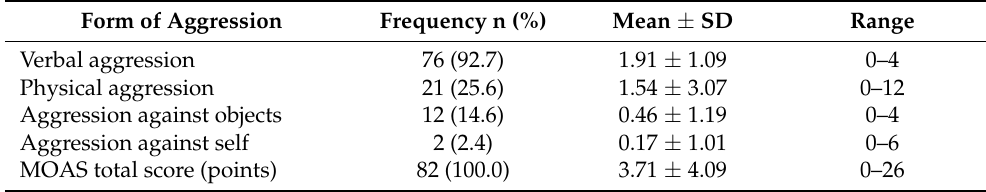
Table 1. Occurrence and MOAS scores of the four forms of WV (in order of frequency). Form of Aggression Frequency n (%) Mean ± SD Verbal aggression Aggression against